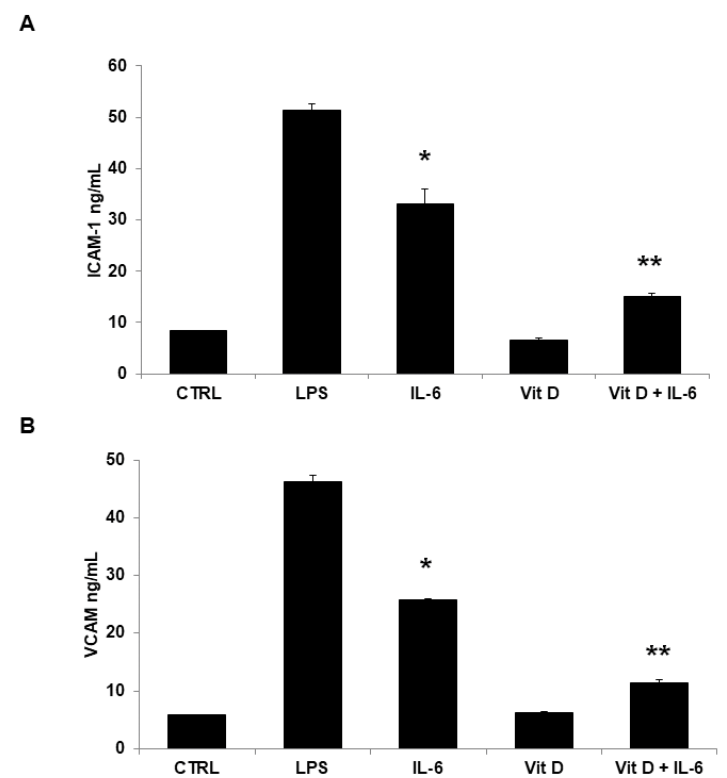
Figure 4 . In basal conditions, very low basal levels of soluble ICAM-1 and VCAM-1 were measured in the HUVEC supernatants. Stimulation with IL-6 increased significantly the supernatant